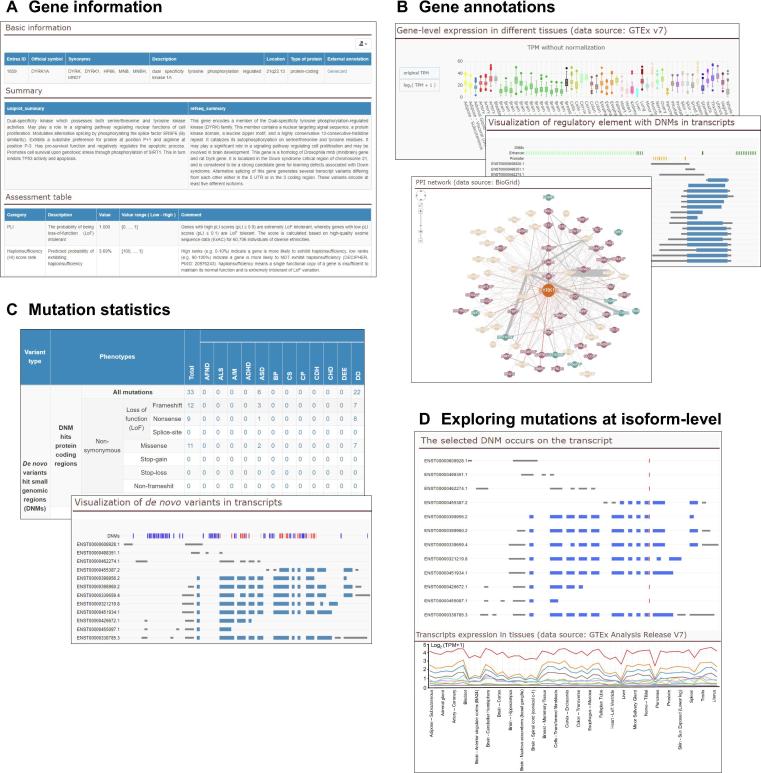
Web interface of PsyMuKBA snapshot of the major functionalities of PsyMuKB using neuropsychiatric-related gene DYRK1A as an example. A. General information about DYRK1A, including description, summaries, and gene pathogenicity assessment. B. The information about the expression, associated regulated element, PPIs of DYRK1A. C. The mutation summary table of DYRK1A and the visualization of genomic locations of mutations in different transcripts. D. The interface for identifying the isoform-specific mutations of DYRK1A using the tissue-specific expression of isoforms and their exon–intron structure map. PPI, protein–protein interaction.